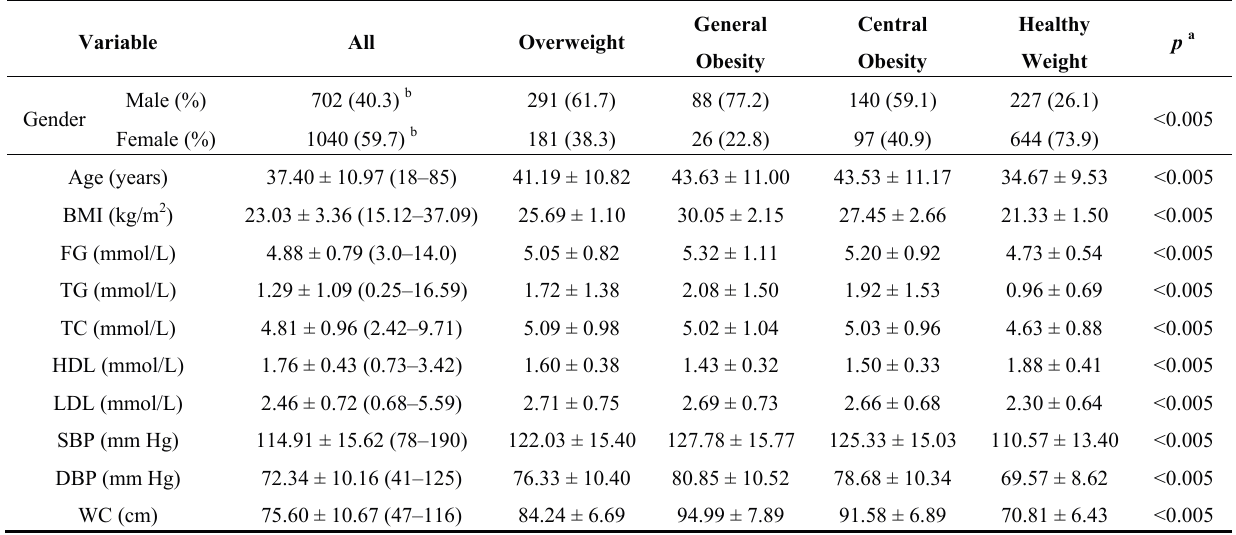
BMI, body mass index; FG, fasting glucose; TG, triglyceride; TC, total cholesterol; HDL, high-density lipoprotein; LDL, low-density lipoprotein; SBP, systolic blood pressure; DBP, diastolic blood pressure; WC, waist circumference; a Comparison between overweight + general obesity and healthy weight, Chi-square test for difference of distribution of BMI status between male and female, Student’s t test for other variables; and b BMI of 96 males and 189 females was not measured due to personal reasons.